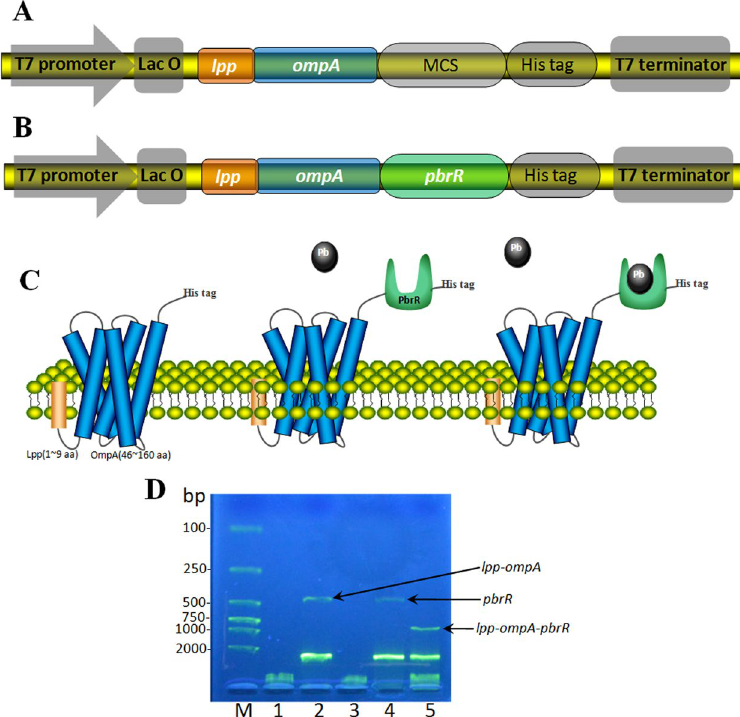
Figure 1. Constructions in this study. Schematic diagrams of pLA ( A ) and pLAP ( B ) cloning/ expression regions and PbrR displayed on the outer membrane of E . coli ( C ). 2% agarose gel electrophoresis analysis of double restriction enzyme digestion of pLA and pLAP ( D ). Land 1: undigested pLA; Lane 2: pLA digested with Nde I and Sal I; Lane 3: undigested pLAP; Lane 4: pLAP digested with Hin dIII and Xho I; Lane 5: pLAP digested with Nde I and Xho I; Lane M: a low molecular weight DNA